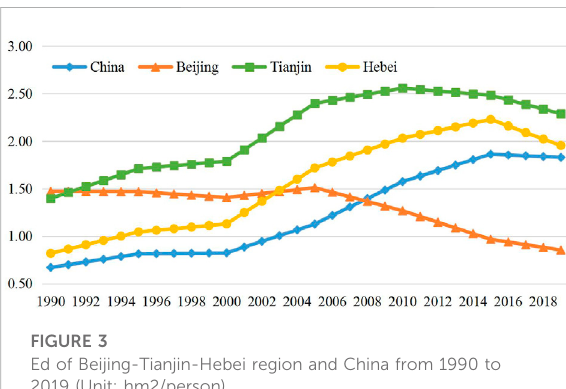
FIGURE 1 Ef of Beijing-Tianjin-Hebei region and China from 1990 to 2019 (Unit: hm2/person).